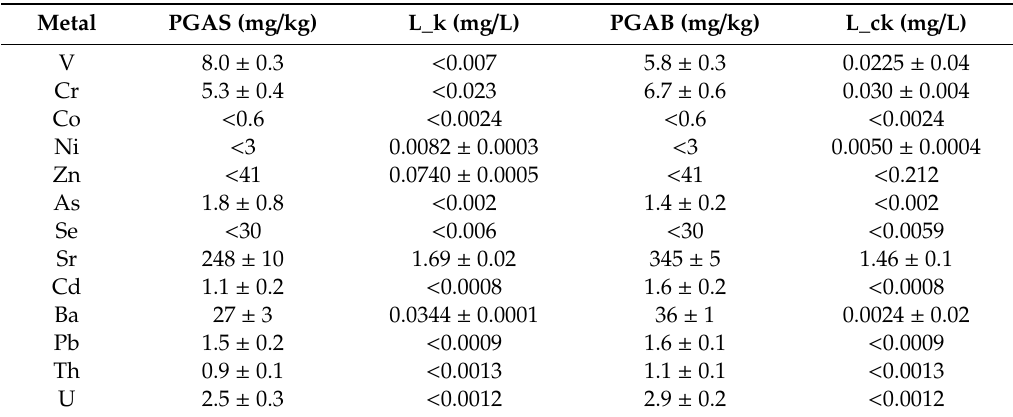
Table 4. Contents of trace elements in the PGAS (katoite precipitate) and PGAB (calcite) samples. Leaching results obtained from the application of the TCLP (Toxicity Characteristic Leaching Procedure) technique to the PGAS (L_k) and PGAB (L_ck)